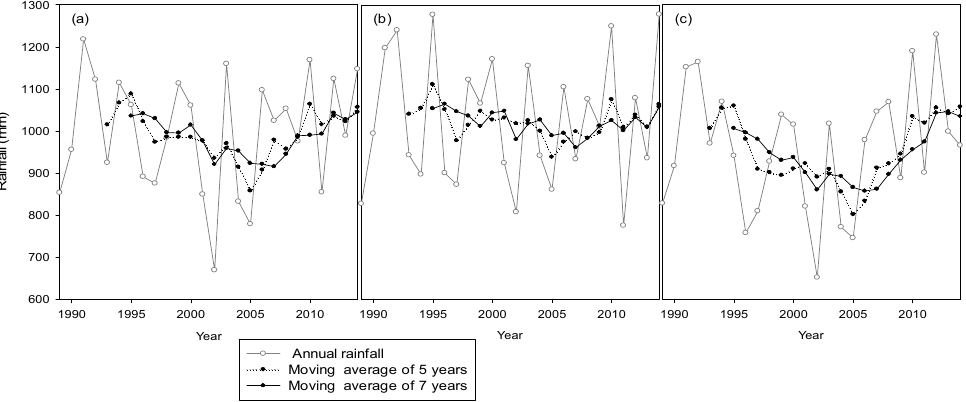
Figure 7. Average annual rainfall and five-year and seven-year moving averages over the past 25 years. ( a ) Thiessen average rainfall over the Kou catchment; ( b ) rainfall at the Bobo-Dioulasso station; and ( c ) rainfall at the vallée du Kou station (most downstream station).